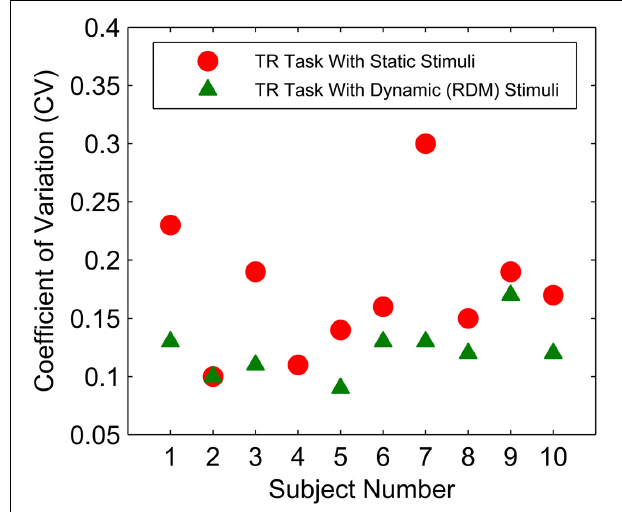
FIGURE 10 | CV values obtained in the temporal reproduction task with two different types of stimuli (red circles for static stimuli & green triangle for dynamic stimuli) for each subject. Subject 4 did not participate in the second TR session with dynamic